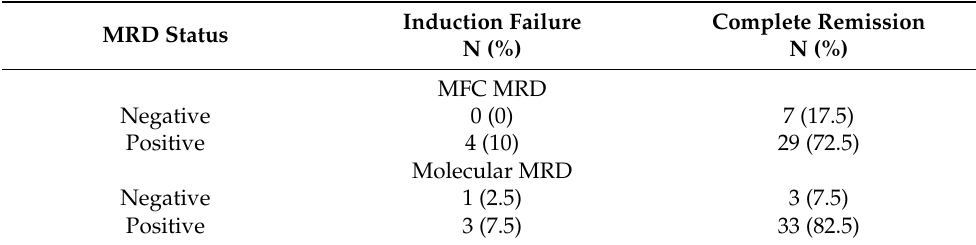
Table 2. Clinical correlations at